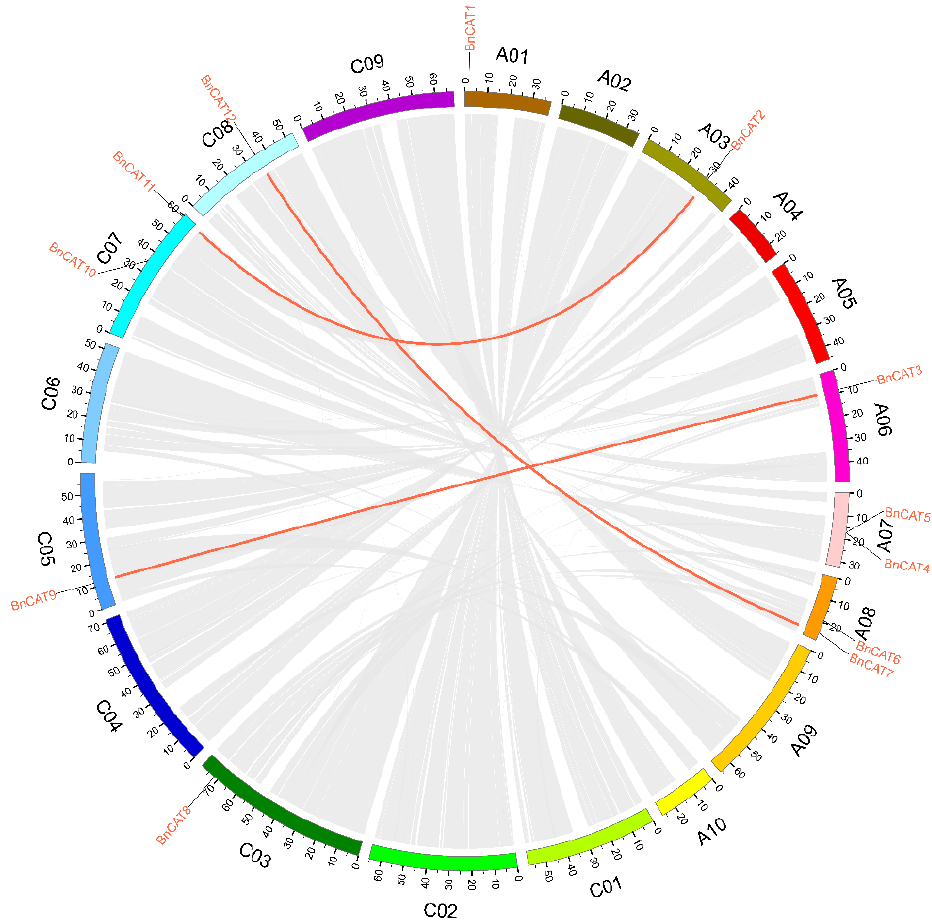
Figure 2. Circular illustrations of the chromosomal dispersal and inter-chromosomal associations of BnCAT genes. Grey lines in the background show all the syntenic blocks in the rapeseed genome, and the red lines show syntenic CAT gene pairs.